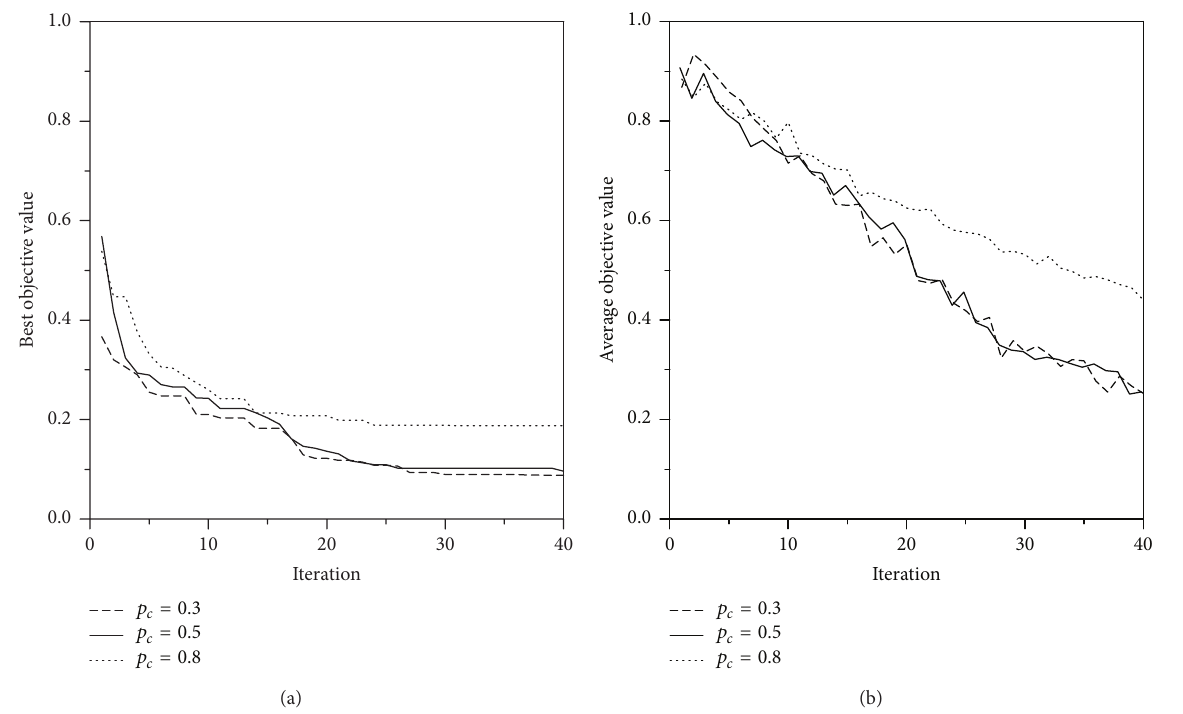
Figure 12: Convergence histories of (a) best objective value and (b) average objective value for 𝑝 𝑐 = 0.3 , 𝑝 𝑐 = 0.5 , and 𝑝 𝑐 = 0.8